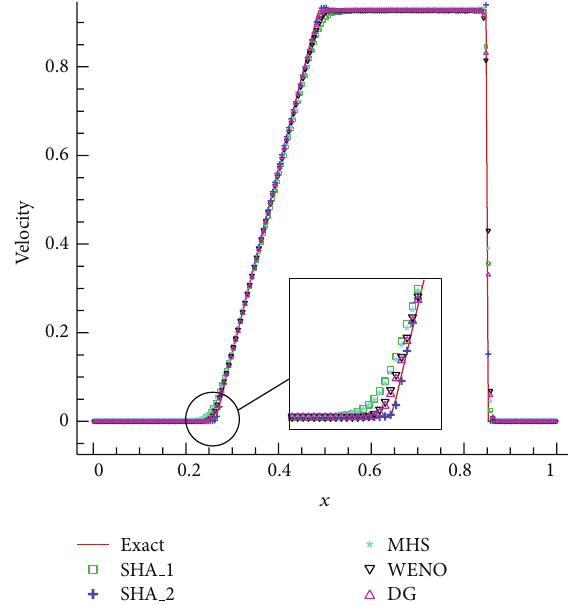
Figure14:Velocitycomparisonofschemesattime0.2unitsforSod’s tube problem.